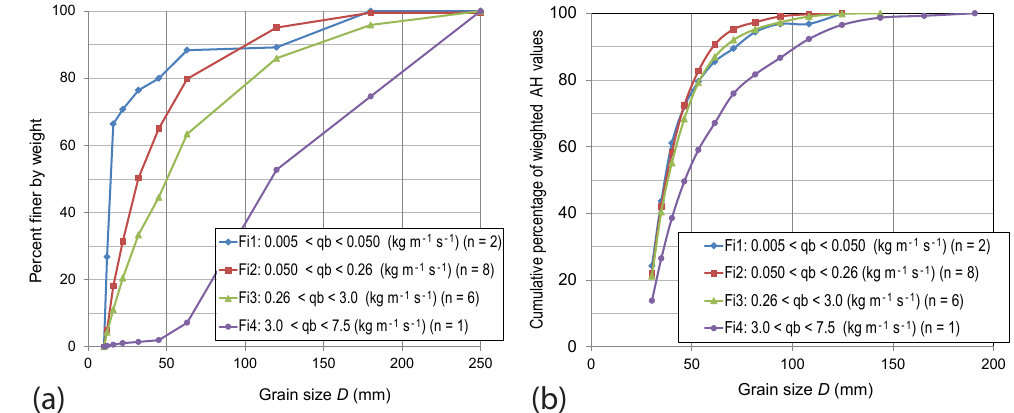
Figure 11. Fischbach: (a) grain size distributions derived from the calibration bedload samples (for D > 10mm), averaged for four classes of bedload fluxes q b (using 17 samples from 2010 to 2012); (b) relative distribution of grain sizes estimated from the geophone measurements based on the AH data, averaged for the same four classes of bedload fluxes (using the same 17 sample periods from 2010 to